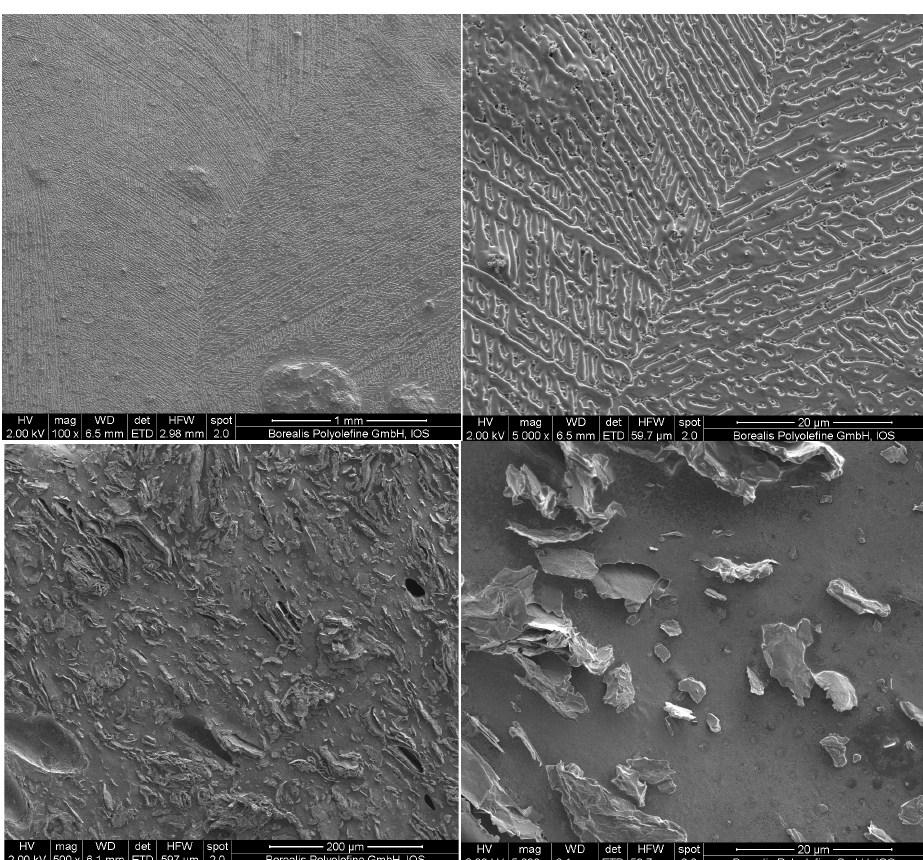
Figure 2. SEM micrographs of EVA20/CB ( top ) and EVA20/GNP M − 25 ( bottom ). We now turn to the details of the dielectric behaviour of the composites. EVA can be classified as a type-B or C polymer in Stockmayer’s classification [51], as the permanent dipoles are attached perpendicular to the main chain and have some degree of freedom, permitting internal rotation. This dipole can be measured with accuracy employing di- electric spectroscopy and be used as a sensitive probe of segmental relaxation. Figure 3a gives dielectric loss spectra for the segmental relaxation of EVA measured under isothermic conditions. It is apparent that a superposition of the isobaric relaxation spectra is not possible, in contrast to the isothermal spectra at different pressures, as reported in the literature [52], i.e., the system is thermorheologically complex at the segmental level. This is most probably due to the fact that the thermal energy is not great enough to break the predominant intermolecular hydrogen bonding. The intensity of the relaxation spectra of the four EVAs with different VA content follow the trend shown in previous studies [53]. However, the interphase between the polymer matrix and the conductive filler is rather sharp, as implied by the fact that the relaxation times of EVA are not affected by the pres- ence of the fillers. In the small loading domain, up to 1.7 vol% GNP and 2.1 vol% CB, the spectra are identical to those of the pure EVA; thereafter, the high conductivity above the conductive threshold masks the weaker dipolar relaxation. This has the implication that the conductive pathway solely consists of units of the conductive filler, leaving the polymer matrix unaffected and thus retaining the desirable thermomechanical properties, allowing a good polymer